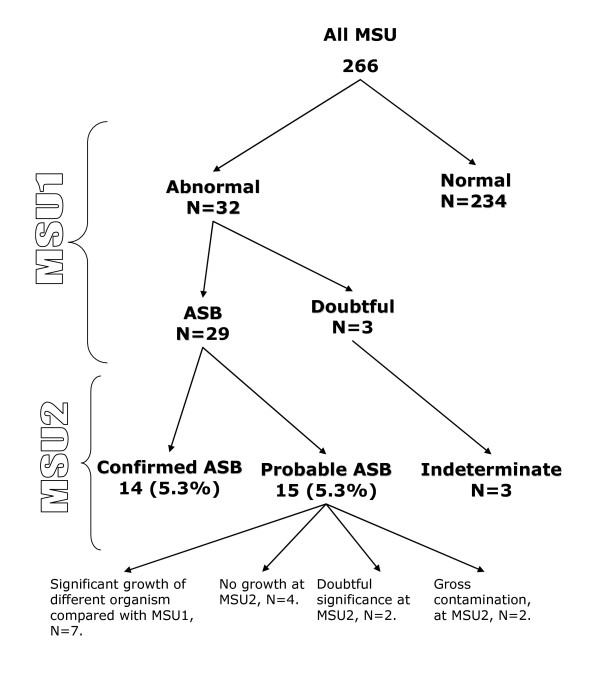
Number of urine samples by microbiological classification.